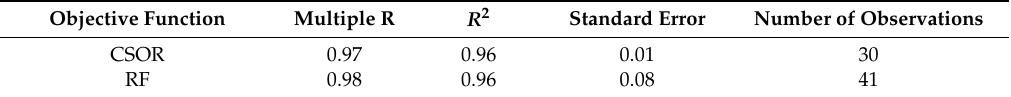
Table 7. Summary of the Statistical Linear Regressions.